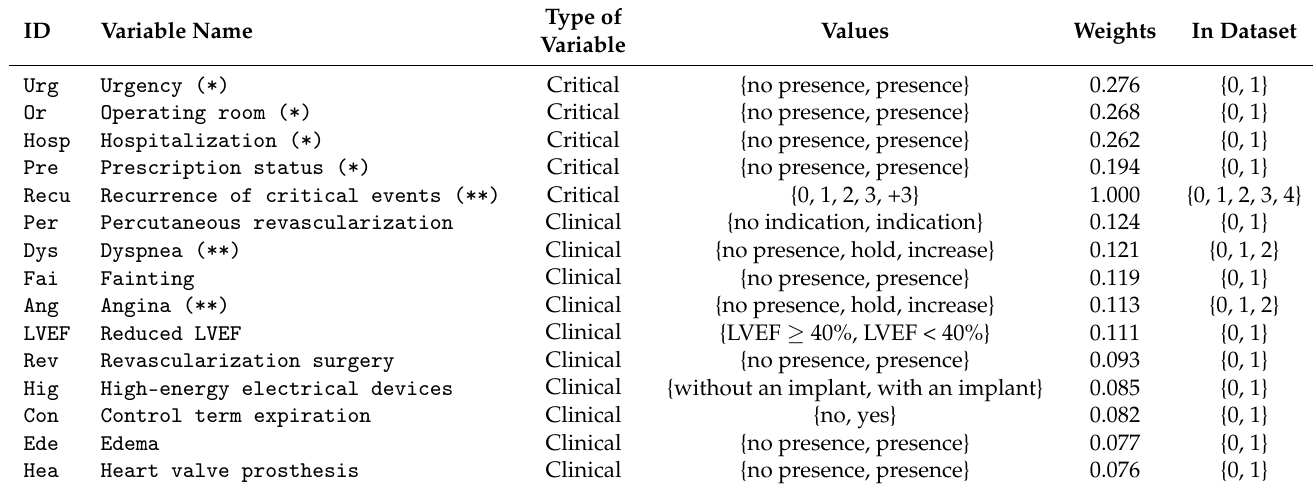
Table 2. The clinical team defines critical and clinical categorical variables to characterize chronic patients under control. (*) the patient with critical events in the last 30 days. (**) variables leveled with one-hot